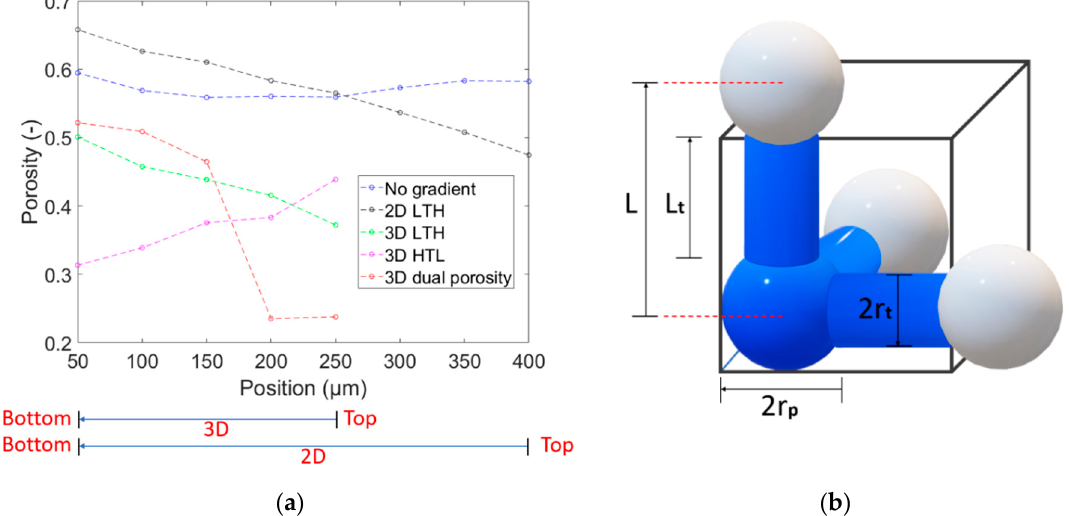
Figure 5. ( a ) Spatial variation of porosity in the 5 cases studied in this work. Only the porosity values of the slices in the center of the pore network are provided. ( b ) Graphical illustration of a volume element used for porosity computation. The blue cylinders and the sphere represent the throats and the pore that are accounted for the volume element, respectively. The white spheres represent the pore neighbors from the neighboring volume element. L indicates the lattice spacing, L t is the throat length, and r t and r p are the throat radius and pore radius, respectively.